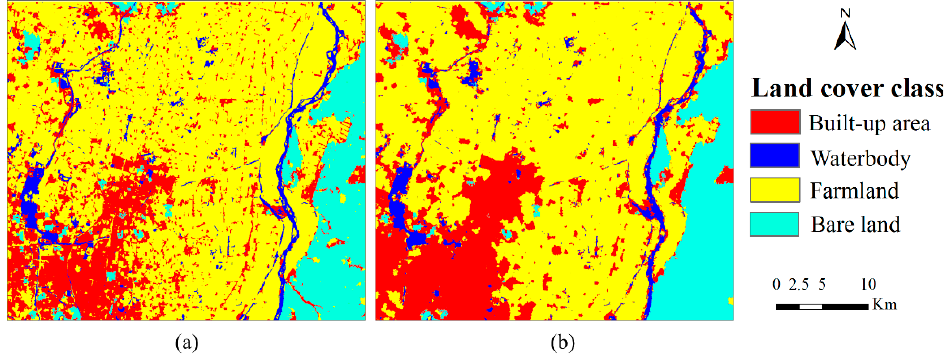
Figure 7. Land use/cover classification results for the Maanshan study area: ( a ) pre-classification map; ( b ) MCRF post-classification map.